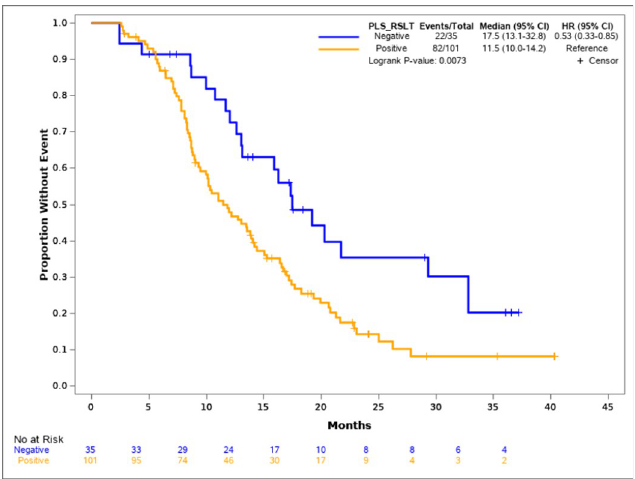
Fig 2. Kaplan-Meier survival analysis of plasma EGFR mutation positive and negative patients. There were 22 events in the 35 patients with negative plasma EGFR mutation, and 82 events in the 101 patients who were plasma EGFR mutation positive. The median PFS was 17.5 months and 11.5 months for the plasma EGFR mutation negative and positive population, respectively, with a HR of 0.53 and significant p value.